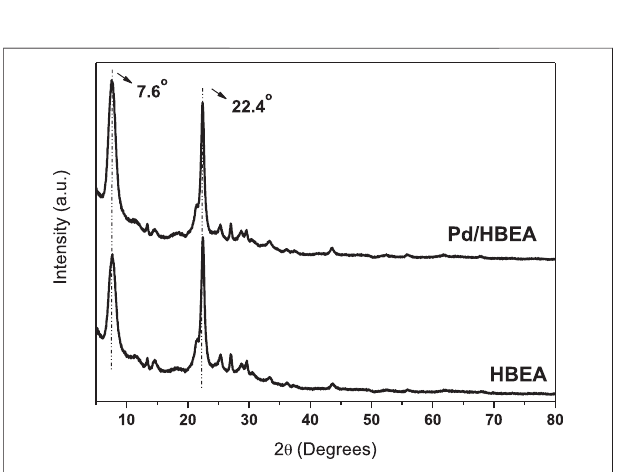
FIGURE 1 | X-ray diffraction patterns obtained from HBEA and Pd/ HBEA catalysts.